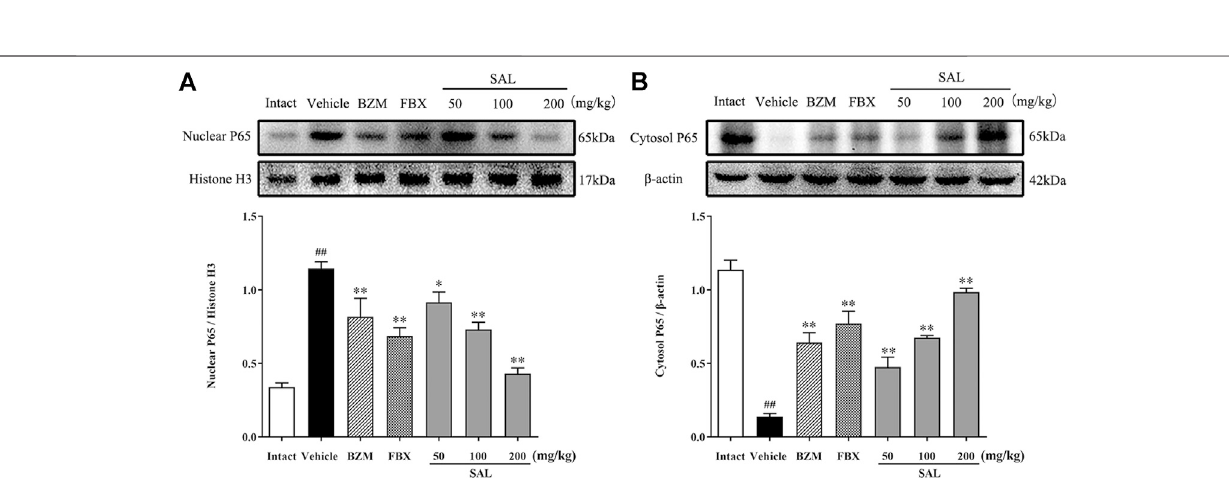
Frontiers in Pharmacology |